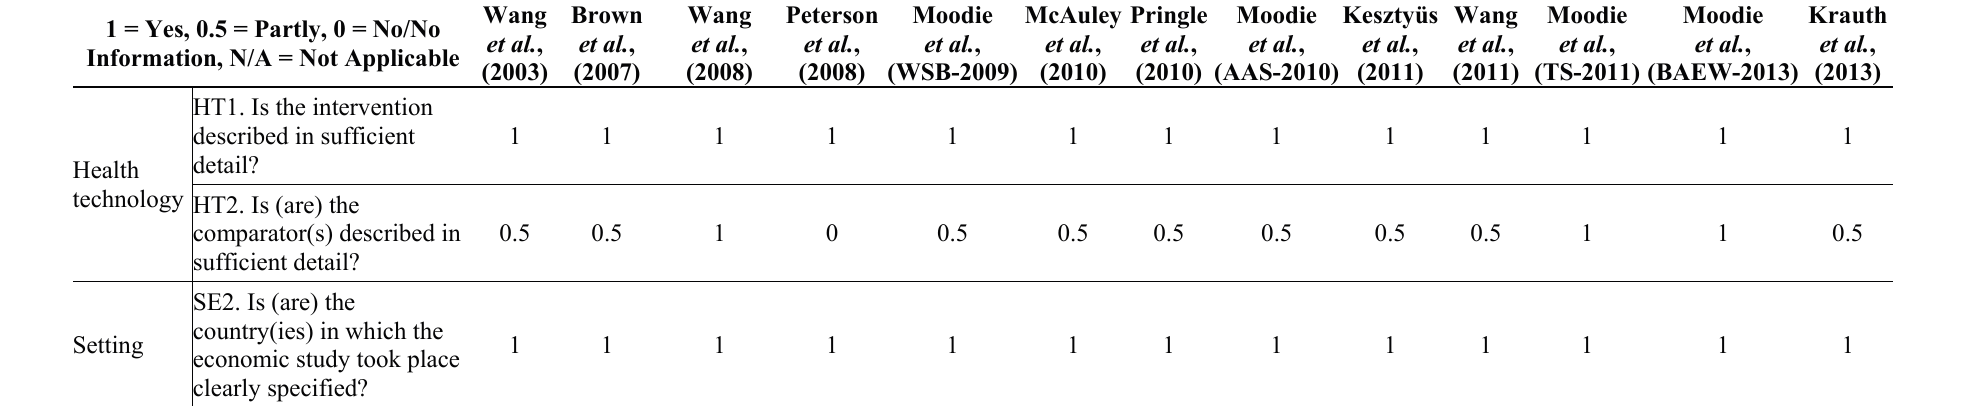
Table 3. Assessment of potential transferability of economic